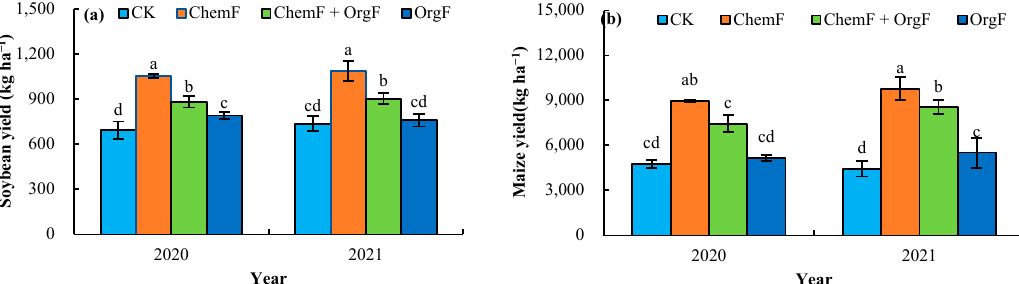
Figure 1. The seeds yield of soybean ( a ) and maize ( b ) with four treatments in soybean–maize intercropping system in 2020 and 2021. CK: no nitrogen fertilizer; ChemF: chemical N fertilizer; ChemF + OrgF: mixture (1:1) of chemical and organic N fertilizer; OrgF: organic N fertilizer. Different letters in each panel indicate significant differences at p = 0.05. Table 1. The changes in protein content (PC), oil content (OC) and total protein–oil content (TP-OC) in soybean undergoing four treatments in 2020 and 2021. Different letters in the same column indicate significant differences at p = 0.05.